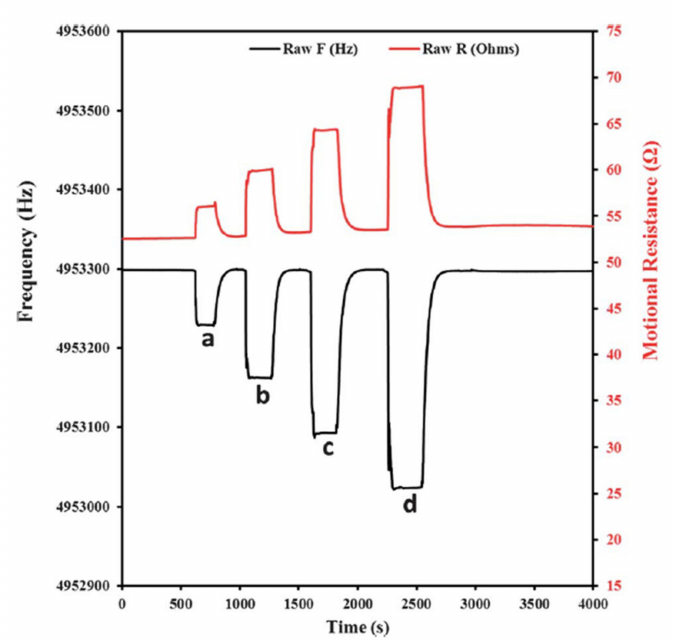
Figure 8. Frequency and resistance changes of a QCM sensor coated with a composite of cellulose acetate and 1-n-butyl-2,3-dimethylimidazolium hexafluorophosphate on exposure to 17.8 mg L − 1 ( a ), 35.6 mg L − 1 ( b ), 53.4 mg L − 1 ( c ), and 71.3 mg L − 1 ( d ) of chloroform vapors. In each case, the liquid sample was injected into the chamber and allowed to vaporize; after equilibrium, the vapor was removed by flushing with UHP argon. Figure is reproduced from [99].